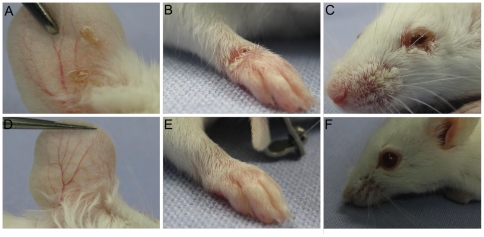
Intraperitoneal injection of BP180/CXVII-specific IgG induces blister formation in adult mice.Skin lesions, including blisters, erosions, and crusts developed on the (A) ear, (B) front leg and (C) periocular area in a BALB/c mouse pre-sensitized with rabbit IgG and subsequently receiving, over a period of 10 days, 6 i.p. injections of IgG, each containing 15 mg of IgG, from a rabbit immunized against murine BP180/CXVII. (D, E, F) A control mouse pre-sensitized with rabbit IgG and challenged with the same dose of normal rabbit IgG showed no skin alterations.